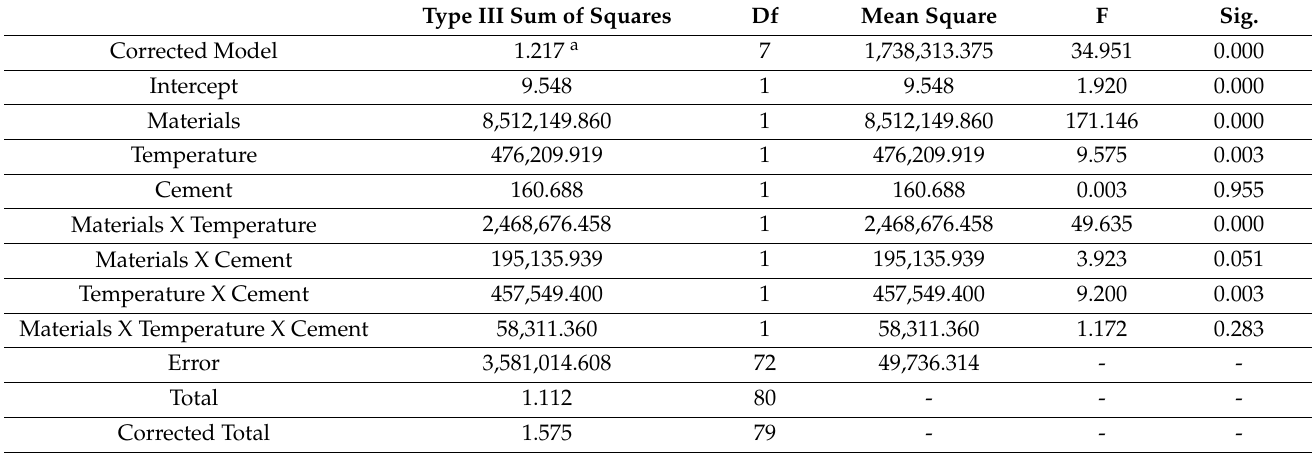
Table 3. Three-way ANOVA test regarding the fracture resistance (N) for the study groups. Type III Sum of